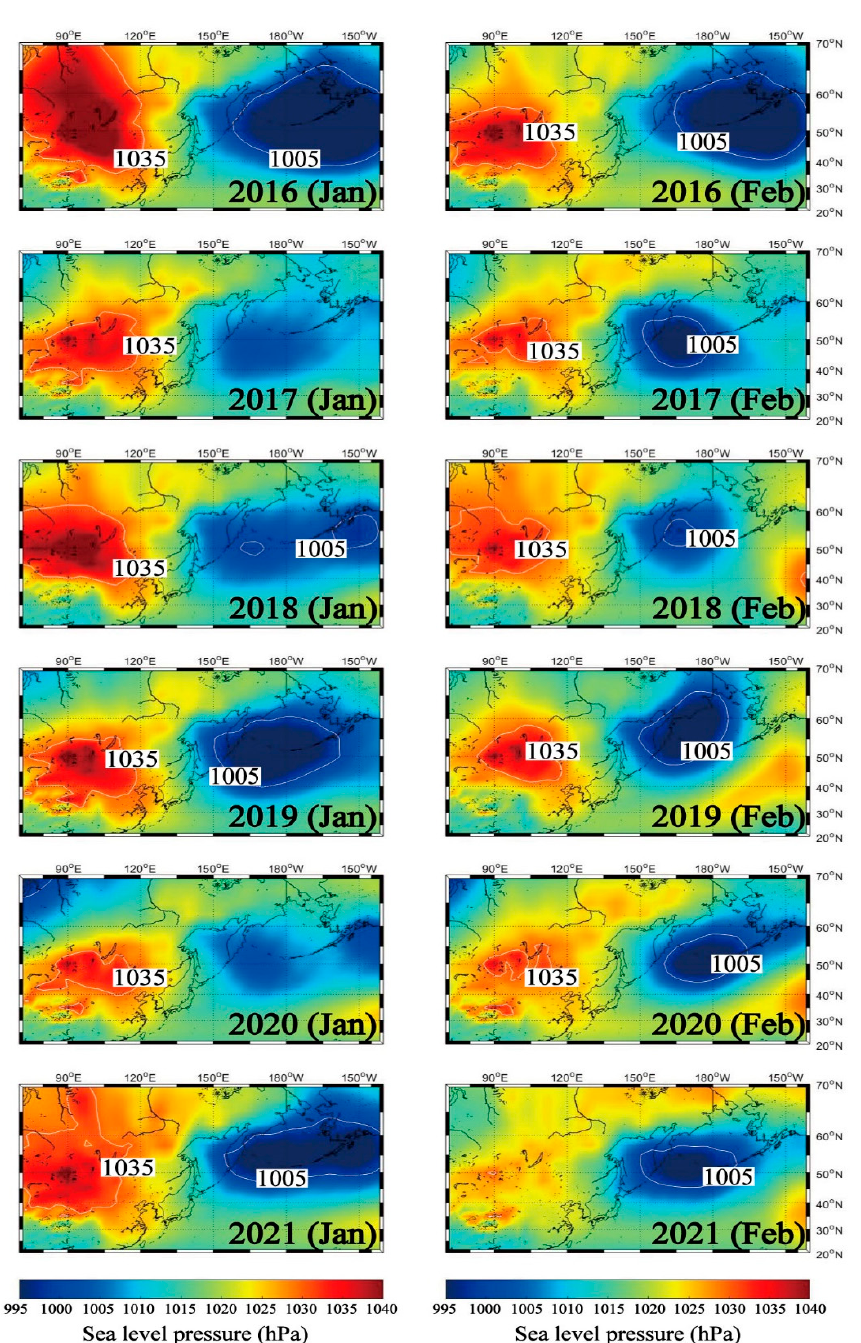
Figure 9. Inter-annual changes in climate index during the months of January and February for the entire time series of 2016–2021.